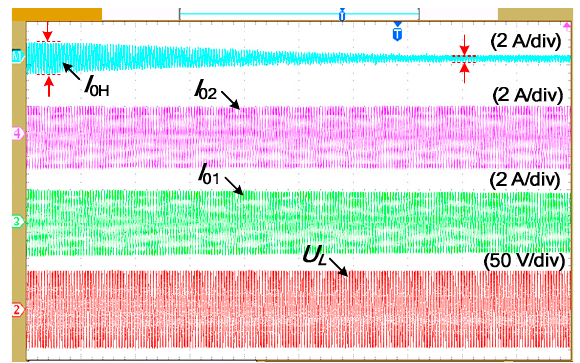
Figure 11. The output current and circulating current waveform of the DG units in transience.